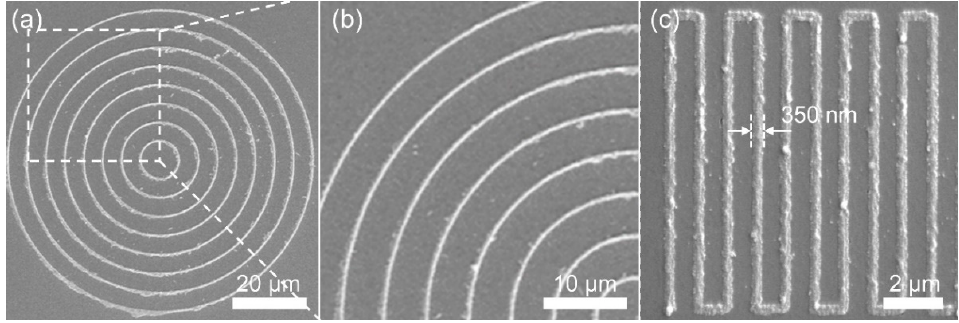
Figure 6. SEM image of silicon oxide nanopatterns, ( a , b ) concentric circles and ( c ) grid.